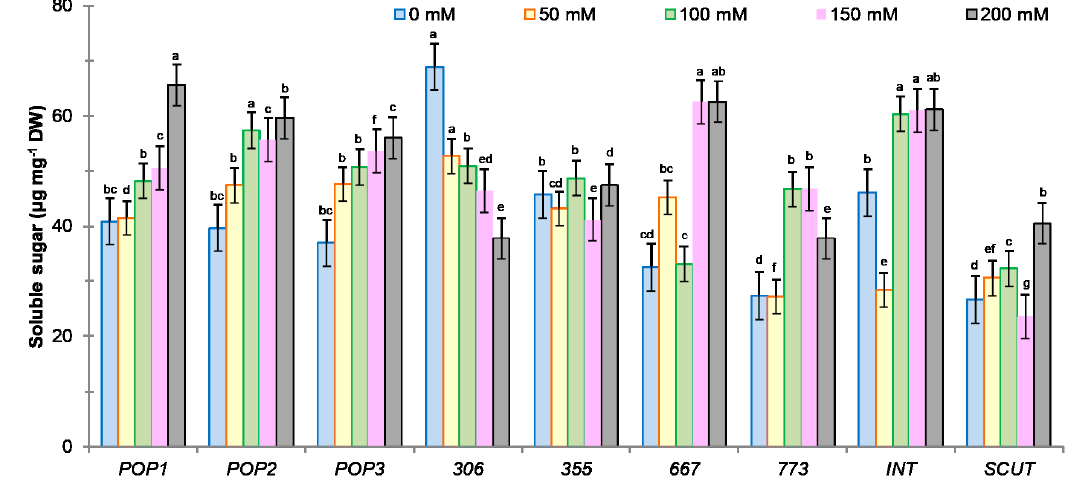
Figure 8. Effect of salt stress concentrations (0, 50, 100, 150, 200 mM NaCl) on leaf sugar content for seven populations of M. ciliaris ( Pop1, Pop2, Pop3, 306, 355, 667, 773 ), compared to one population of M. intertexta ( M. int ) and one population of M. scutellata ( M. scut ). The means are averages of n=5. The standard deviation annotated by different lower-case letters in the same stress type indicate significant differences at p < 0.05 according to Tukey’s post hoc test.